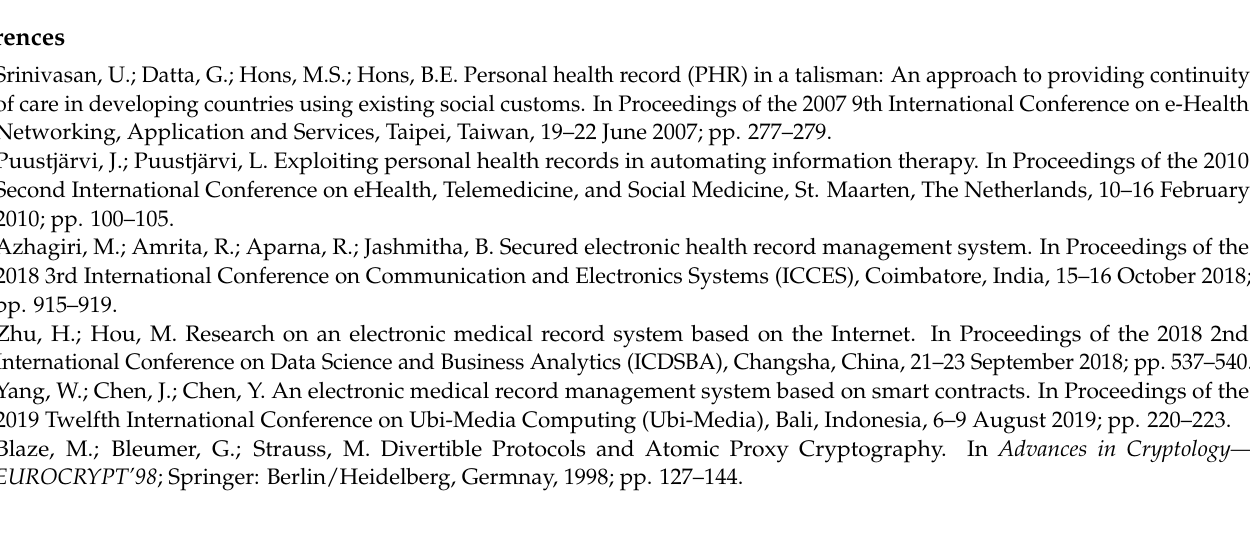
Figure 2. Comparison of various { x , l , k } combinations.